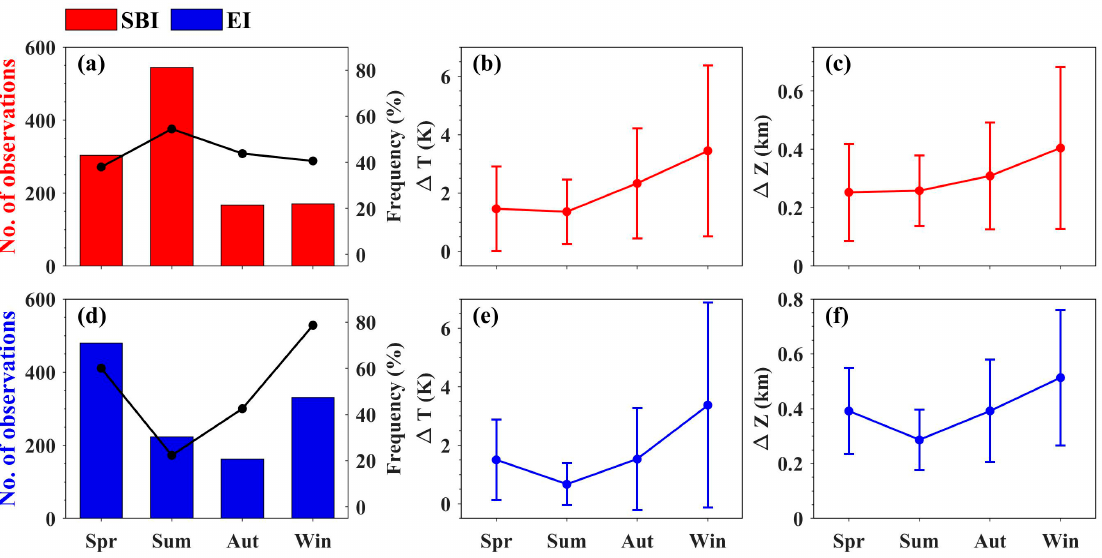
Figure 4. The seasonal variation of ( a ) observation number, ( b ) inversion intensity, and ( c ) inversion depth for SBI. The seasonal variation of ( d ) observation number, ( e ) inversion intensity, and ( f ) inversion depth for elevated temperature inversion. The black line represents the frequency of occurrence.